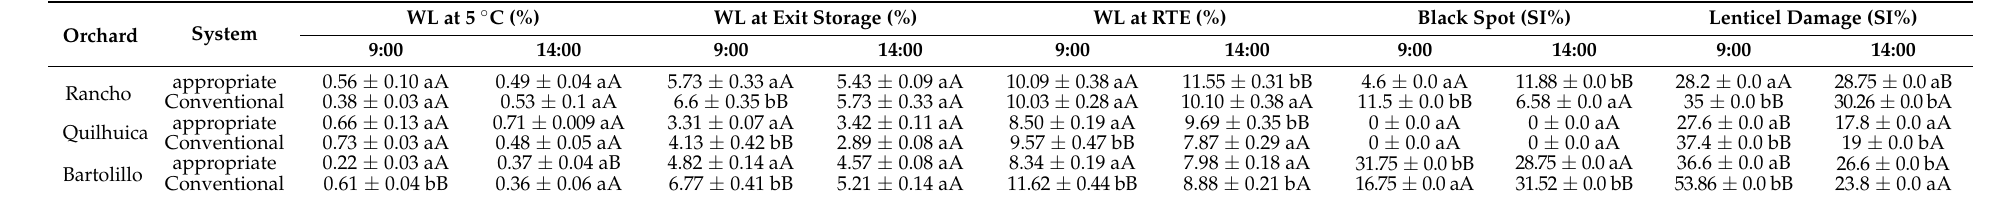
Table 2. Means followed by standard errors of the mean of weight loss (WL) at 5 ◦ C, at exit of the storage, at the ready-to-eat (RTE) stage, severity index (SI%) of black spot and lenticel damage from each orchard evaluated in an independent form at middle harvest. Tukey HSD ( p < 0.05) test was used as a mean comparison test. Lowercase letters compare differences between the harvest systems (i.e., appropriate and conventional) in rows, and uppercase letters compare the differences between the harvest time (i.e., harvest at 9 h and 14 h) in columns for each variable evaluated in an independent